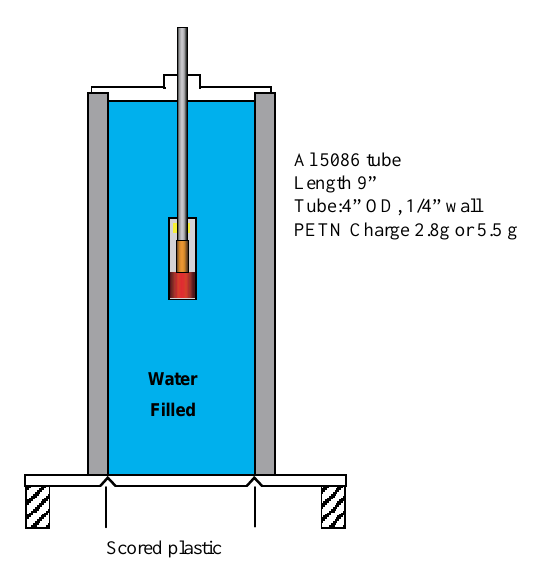
Fig. 5. Single Wall